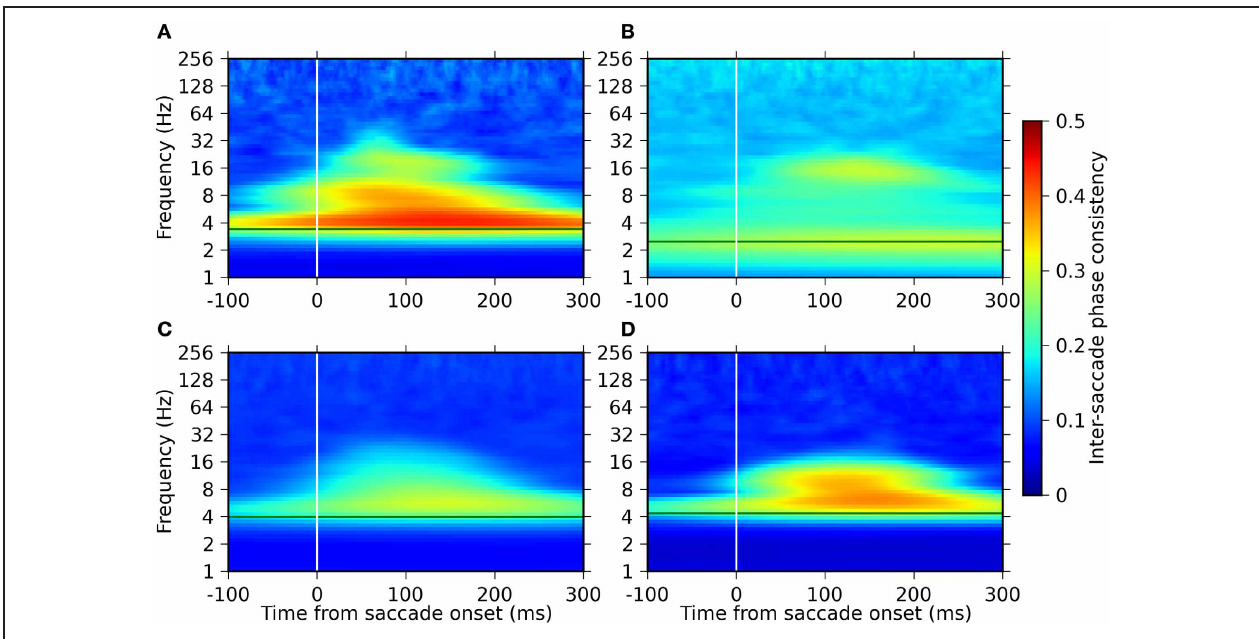
FIGURE 4 | Time-frequency plots of the inter-saccade phase consistency around saccade onset for the four monkeys. Panels (A–D) represent the results of monkeys D, S, M, and G, respectively. The green